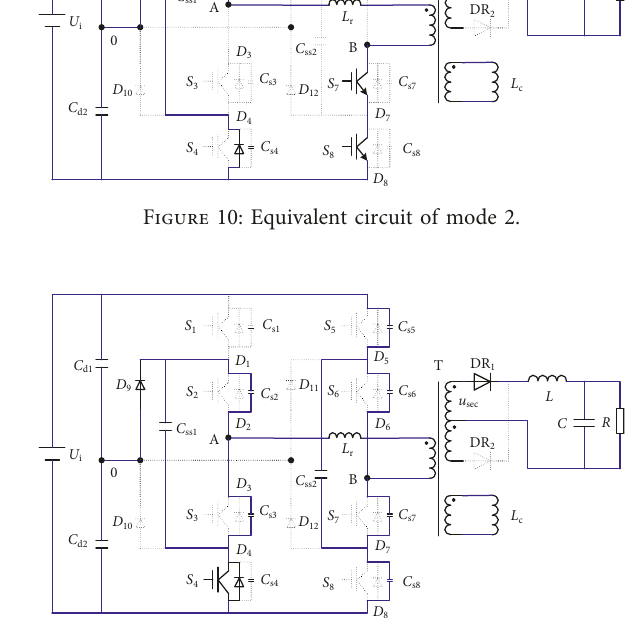
Figure 11: Equivalent circuit of mode